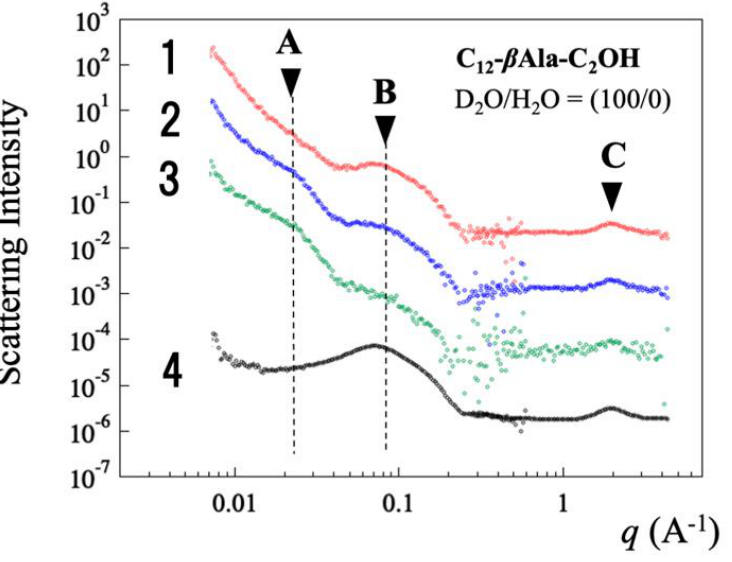
Figure 16. SANS obtained for C 12 –EtOH– β Ala at different heights (No. 1, 2, and 3) and SANS originating from micelles in the solutions of C 12 –EtOH– β Ala (No. 4). For SANS No. 4, the scattering maxima at q m = 0.07 A − 1 (indicated by B) were attributed to interparticle interference between micelles in the solutions, which appeared in SANS (No. 1, 2, and 3) obtained for foams at different heights. The q -behaviors at A and C were attributed to foam film and deuterated water. Broken lines are guides for the